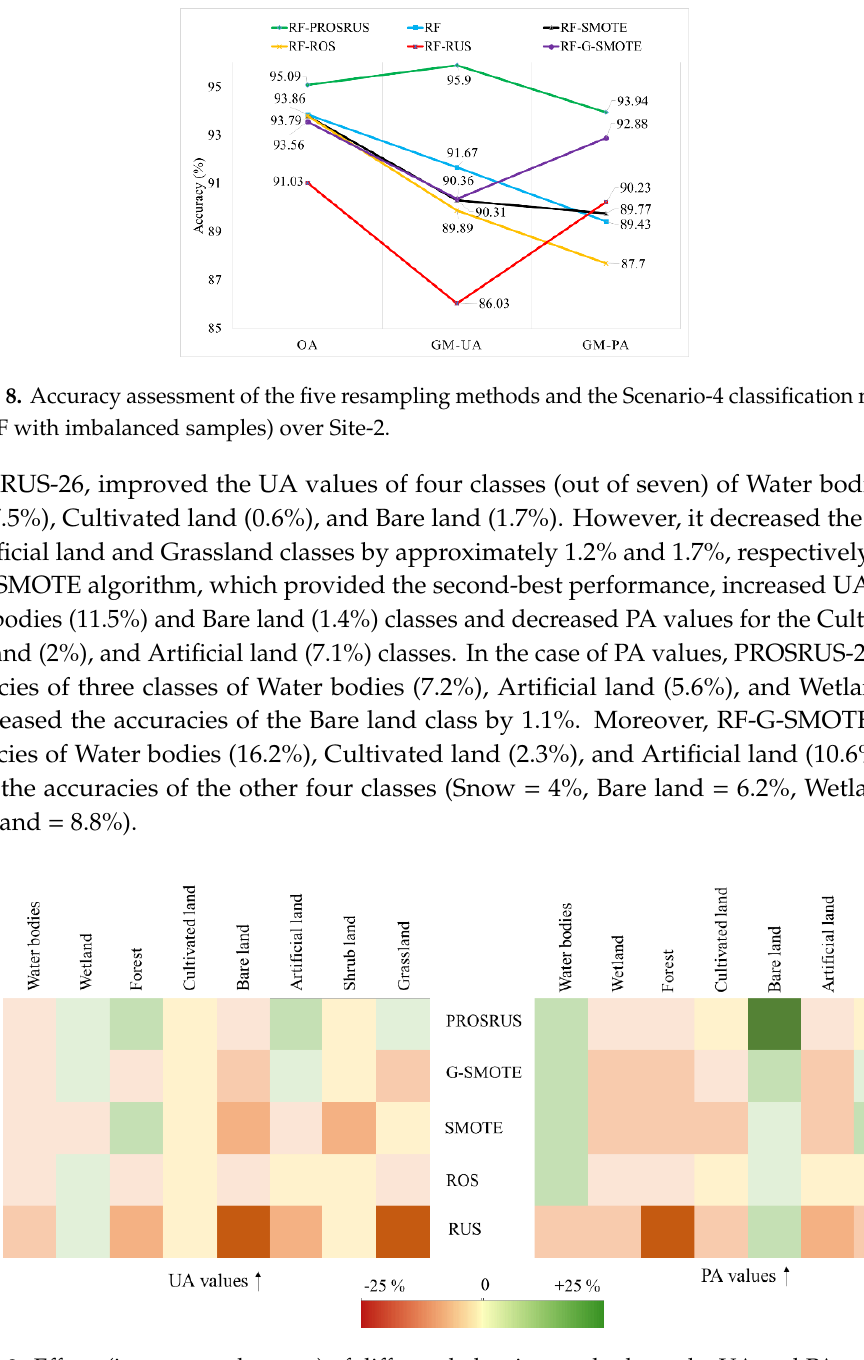
Figure 7. Effects (increase or decrease) of different balancing methods on the UA and PA values of various classes in Site-1. Refer to Appendix C for more information